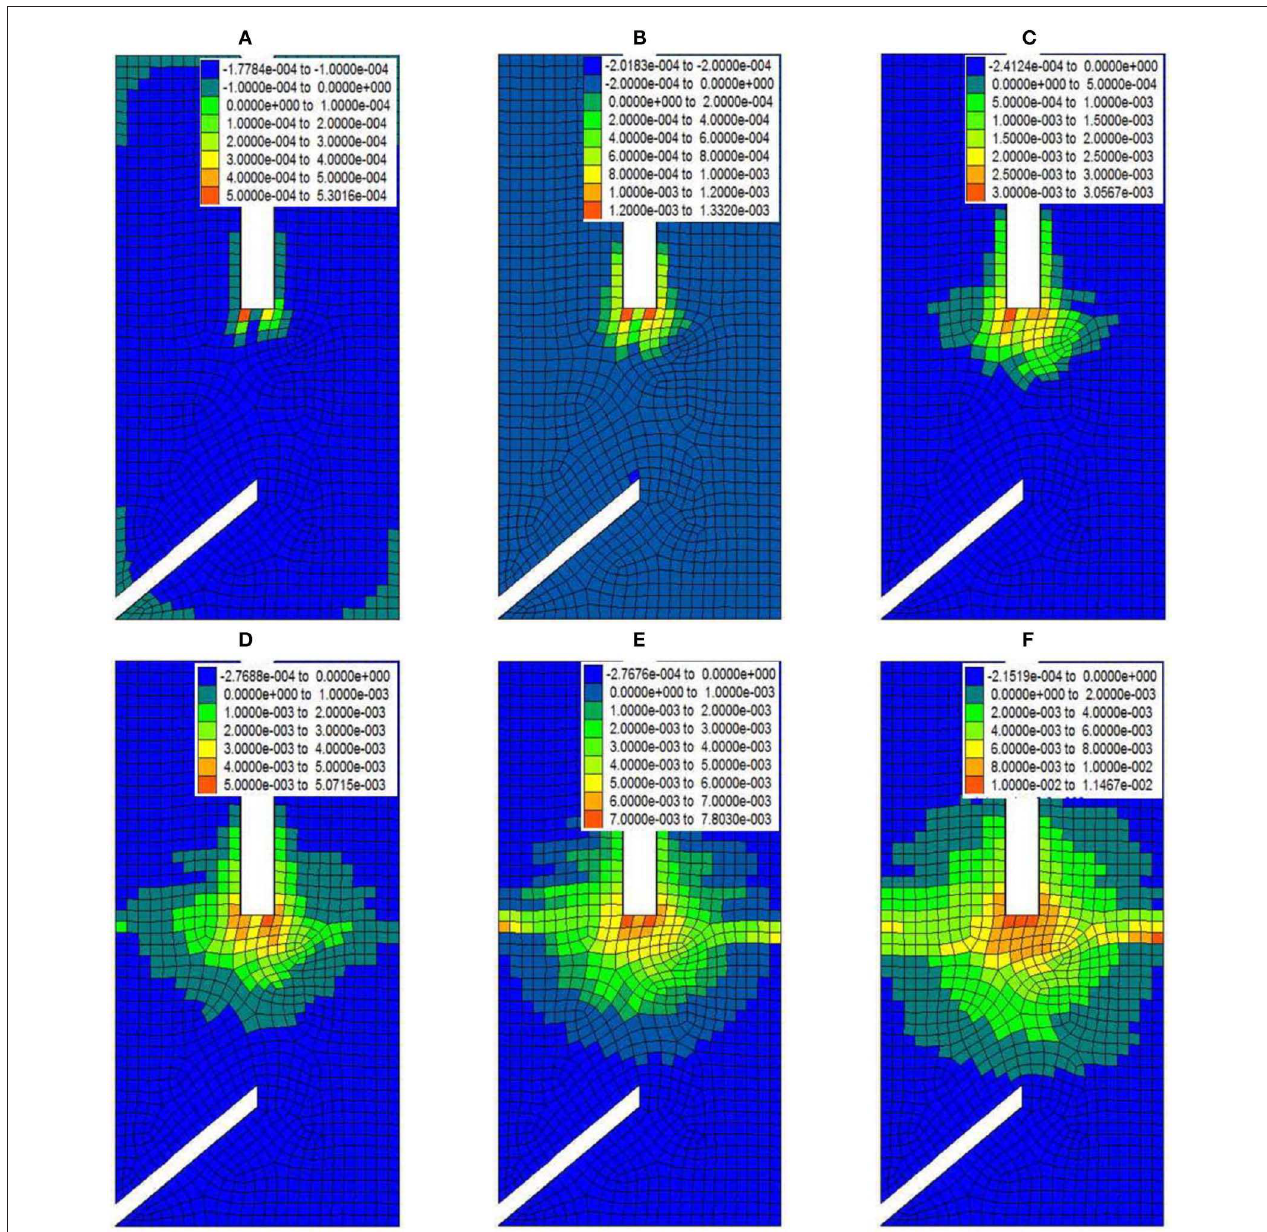
FIGURE 6 | (A–F) Diagram of VSI distribution process of killas